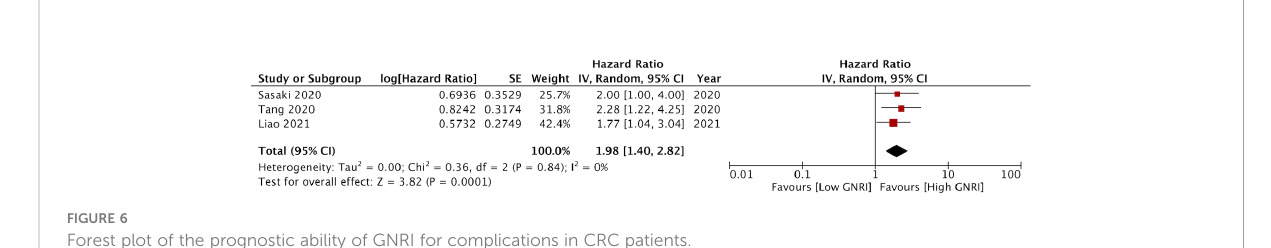
FIGURE 6 Forest plot of the prognostic ability of GNRI for complications in CRC patients.